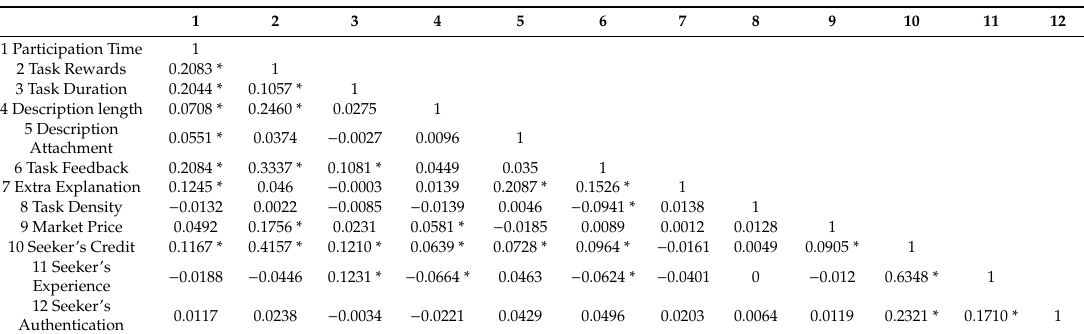
Table 3. Correlation of